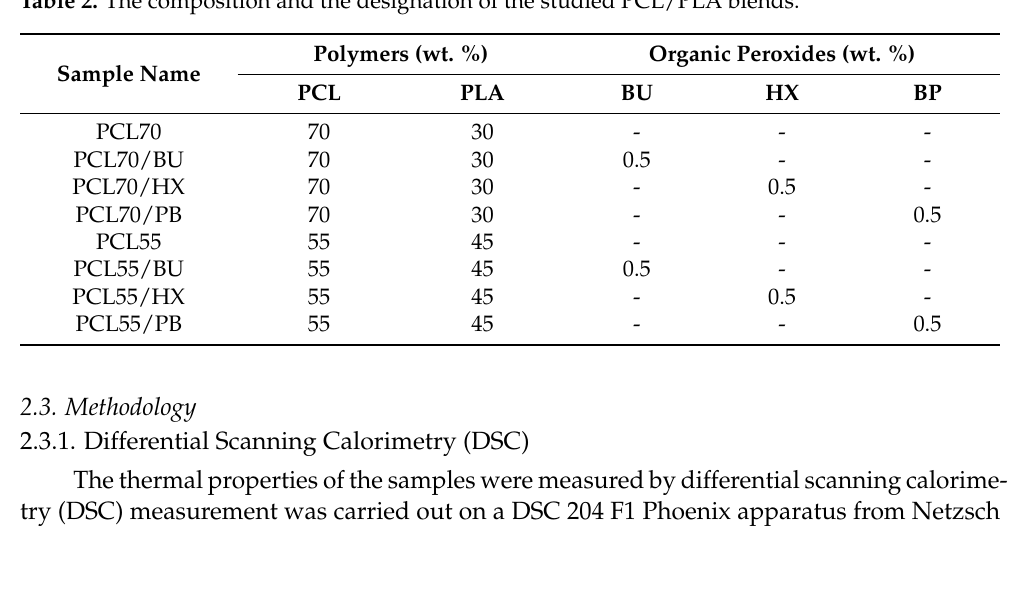
Table 2. The composition and the designation of the studied PCL/PLA